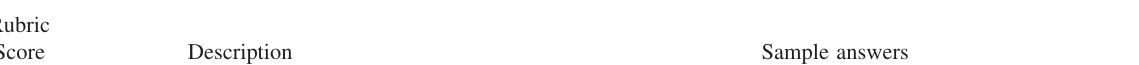
TABLE I. (cid:1) Continued.